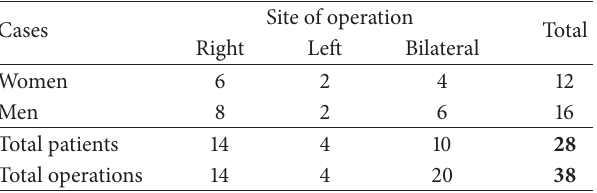
Table 1: Number of patients and operations with